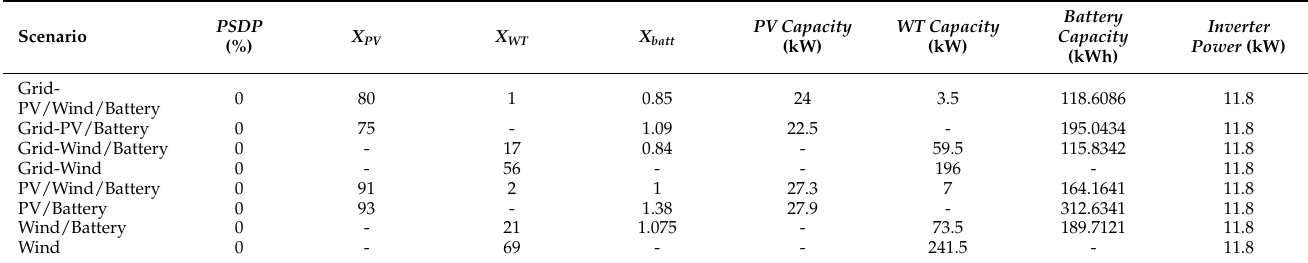
Table 4. Optimal characteristics of the systems components.